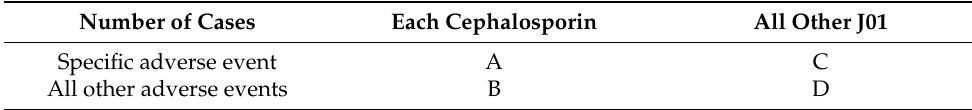
Table 5. Two-by-two contingency table for disproportionality analysis.